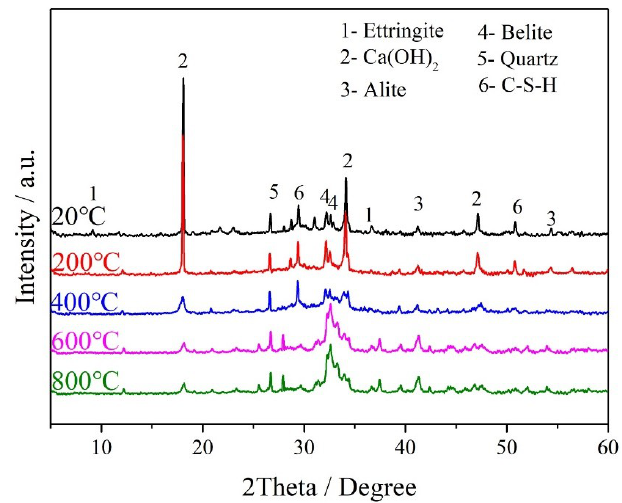
Figure 6. X-ray diffraction (XRD) patterns of cement–metakaolin pastes.